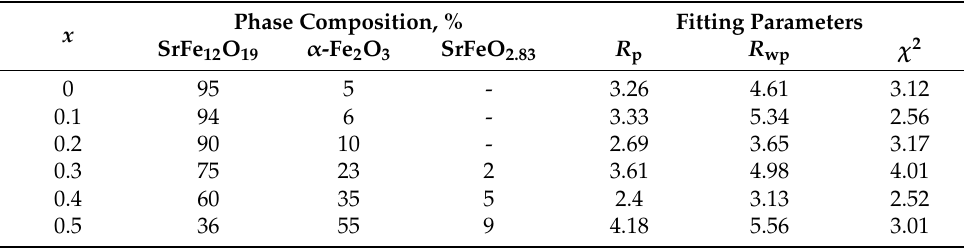
Table 1. The volume fraction of phases and Rietveld parameters of X-ray diffraction spectra of